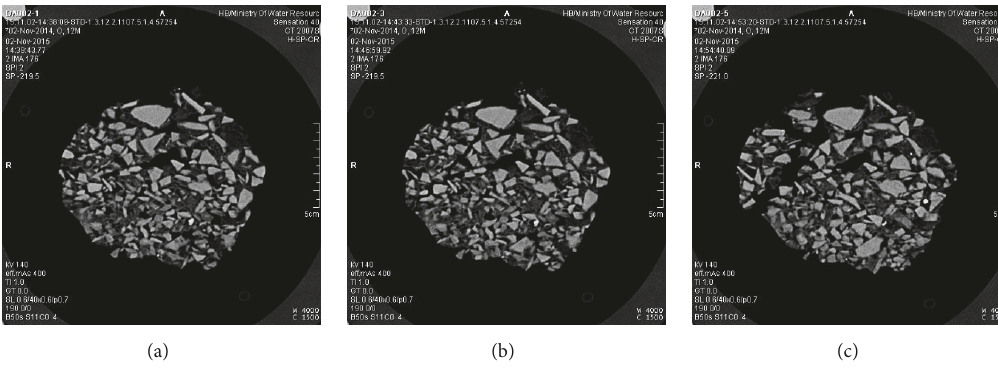
Figure 7: CT scan results for a cracked cross section of the 70-year sample at the same location for different compression